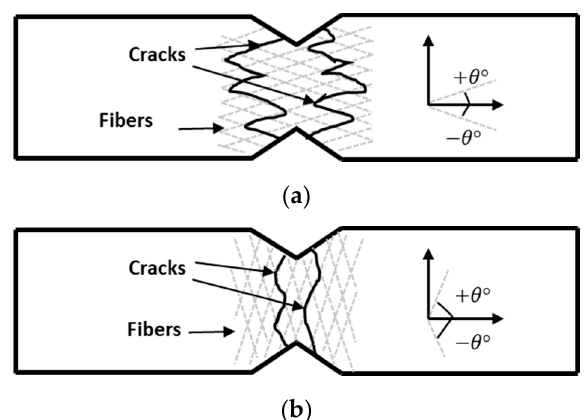
Figure 11. Crack growth in an Iosipescu test sample with fiber orientation ( a ) ±15° and ( b ) ±75°.